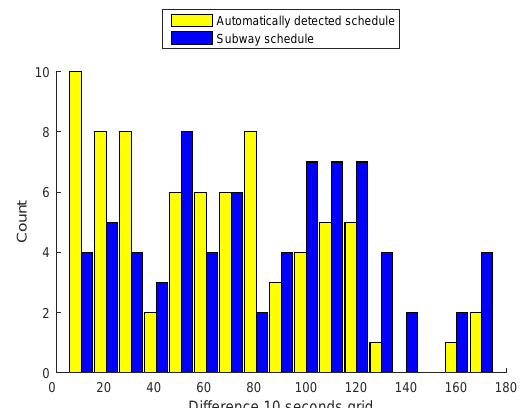
Figure 12: Differences of schedules to the automatically detected subway arrival events